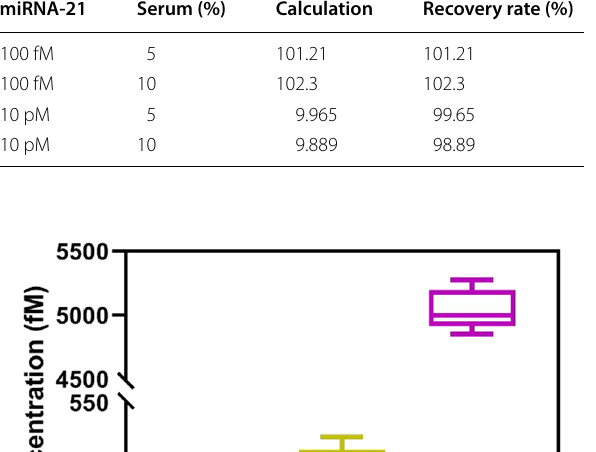
Table 1 Recovery rate of DiRCA for miRNA-21 detection miRNA‑21